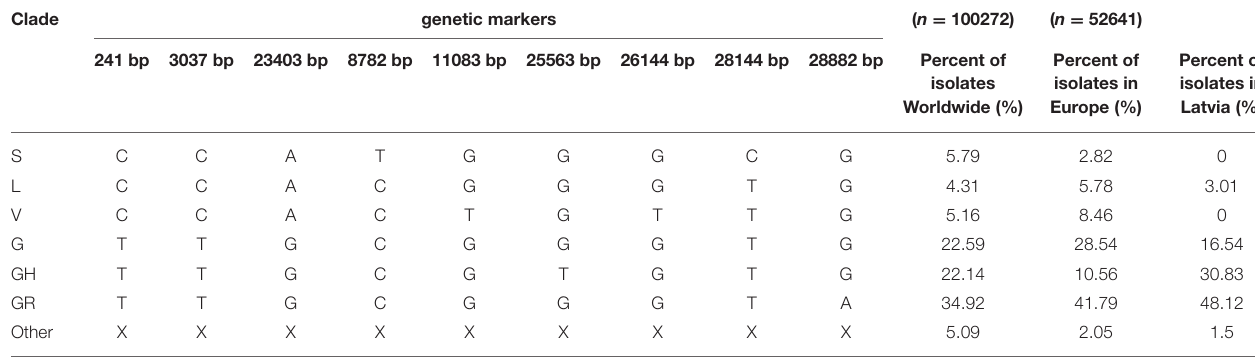
TABLE 1 | Major SARS-CoV-2 clades defining genetic markers and their occurrence in Latvia, Europe, and Worldwide (as of 14 September 2020). Clade genetic